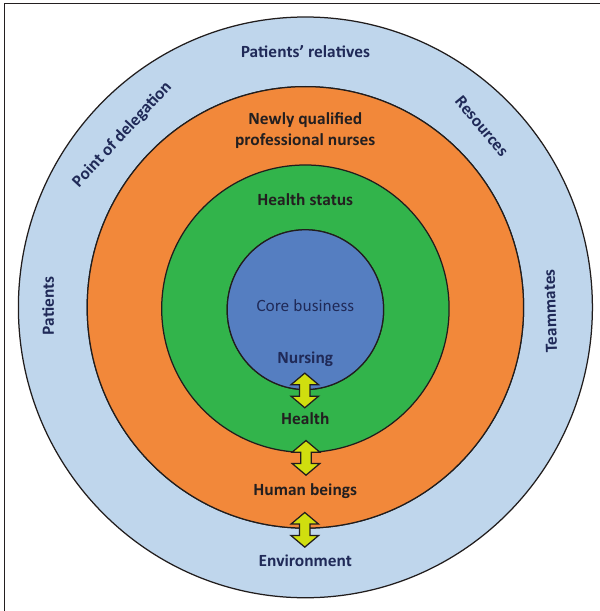
FIGURE 1: A conceptual